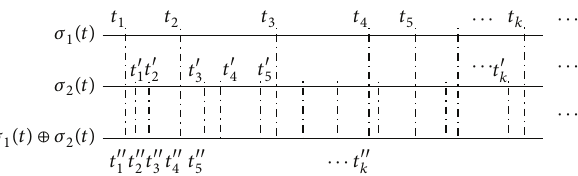
Figure 1: An illustration for the construction of 𝜎 1 (𝑡) ⊕ 𝜎 2 (𝑡)